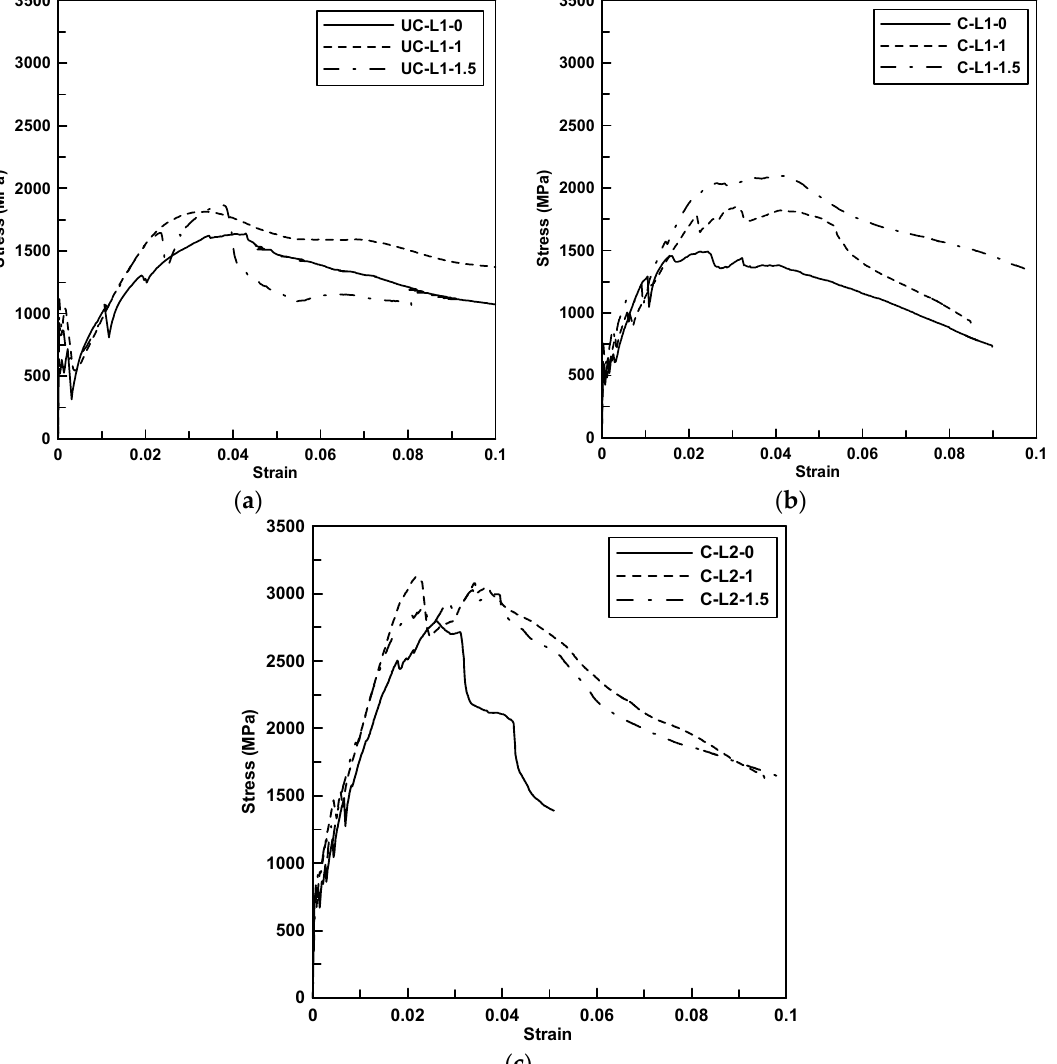
Figure 3. Axial stress versus strain curve of direct tension tested specimens. ( a ) UC-L1 series; ( b ) C-L1 series; ( c ) C-L2 series.